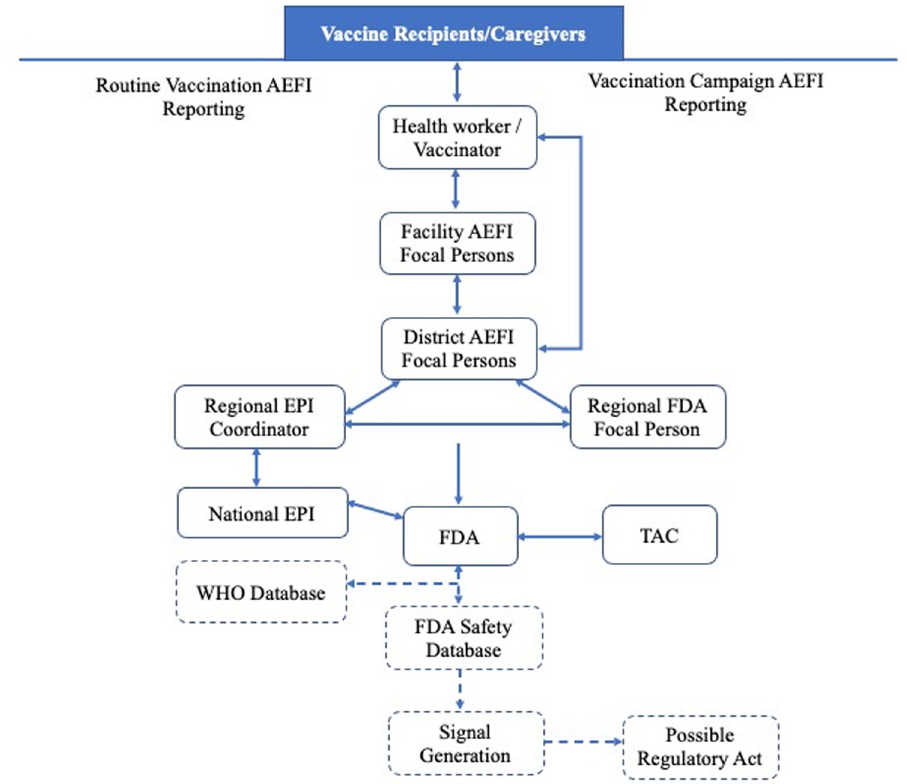
Fig 1. Information pathway, AEFI surveillance system, Ghana. Source: Guidelines for Surveillance of AEFI in Ghana [15].